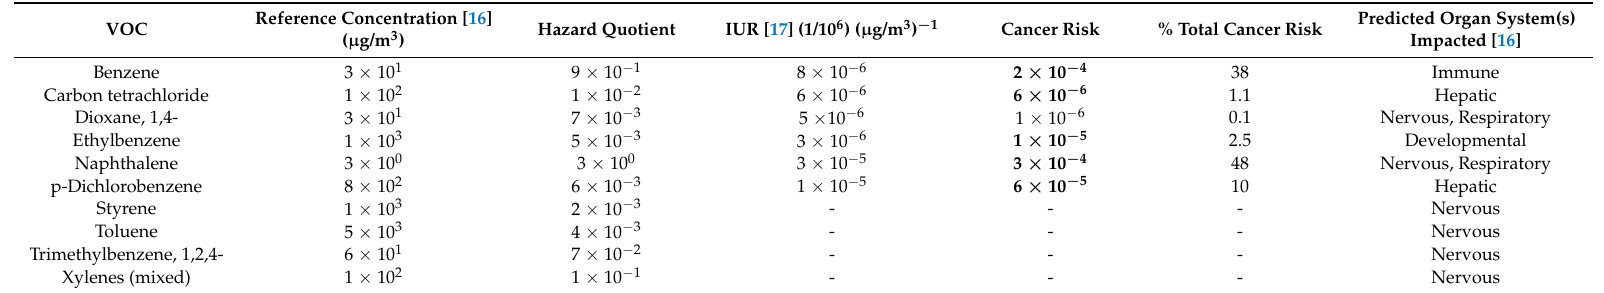
Table 2. VOCs and Estimated Non-Cancer Hazards and Cancer